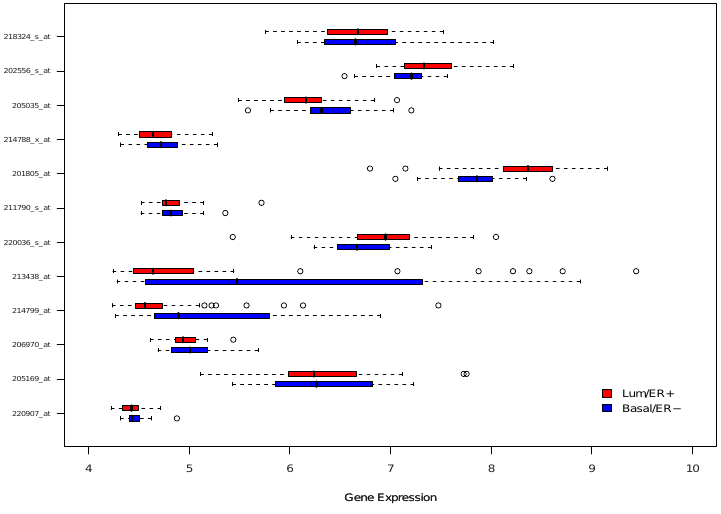
Figure 3: Expression level of the affy probesets mapped from top-ranked